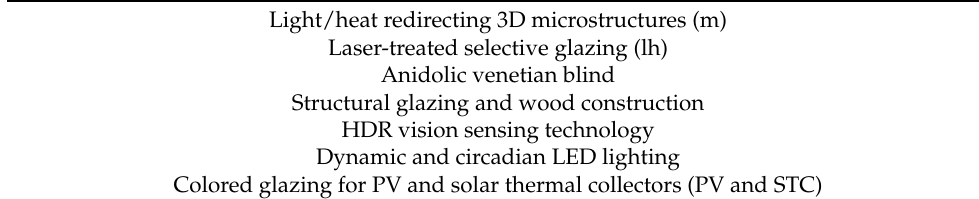
Table 1. List of innovative components installed in the